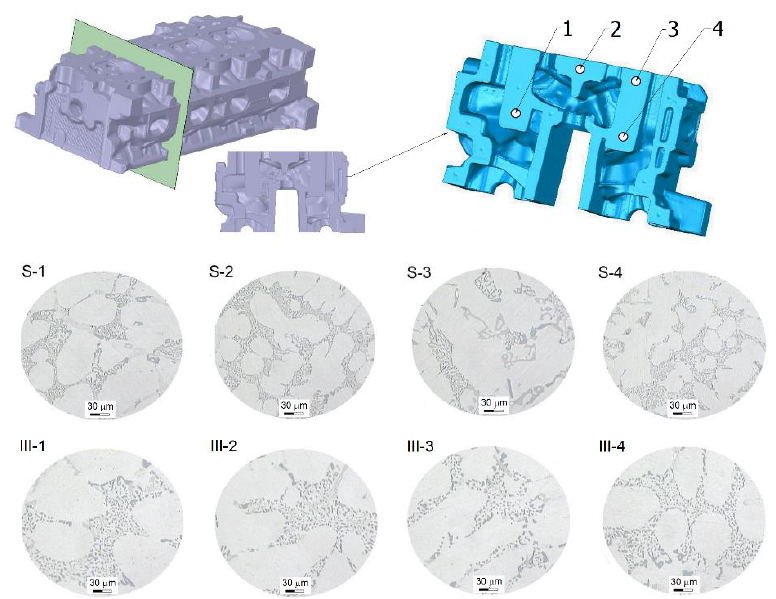
Figure 11. Microstructure in a selected area of the cross-sections of the cylinder head: S—the casting without heat treatment, III—the casting after the heat treatment ( t s = 500 °C, τ s = 1 h, t a = 175 °C, τ a = 2 h).